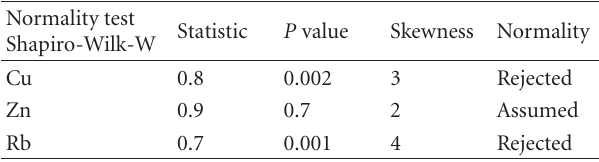
Table 2: Shapiro-Wilk normality test for Cu, Zn, and Rb. Normality